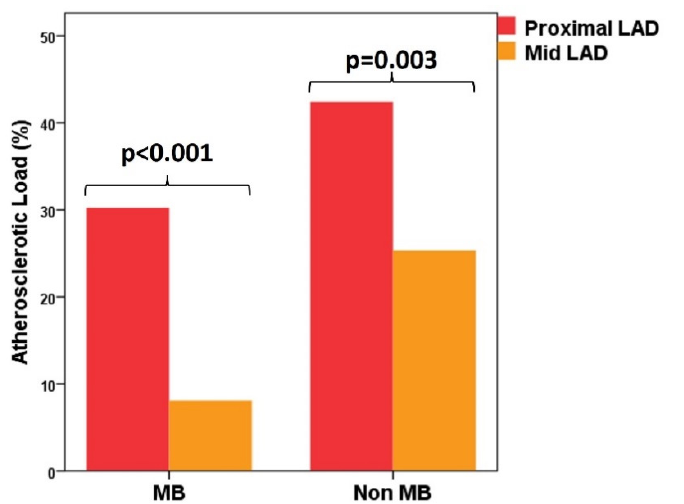
Figure 2. Distribution of atherosclerotic load between the proximal and distal segment of the left anterior descending artery in MB group and non-MB group. LAD—left anterior descending artery; MB—myocardial bridge.